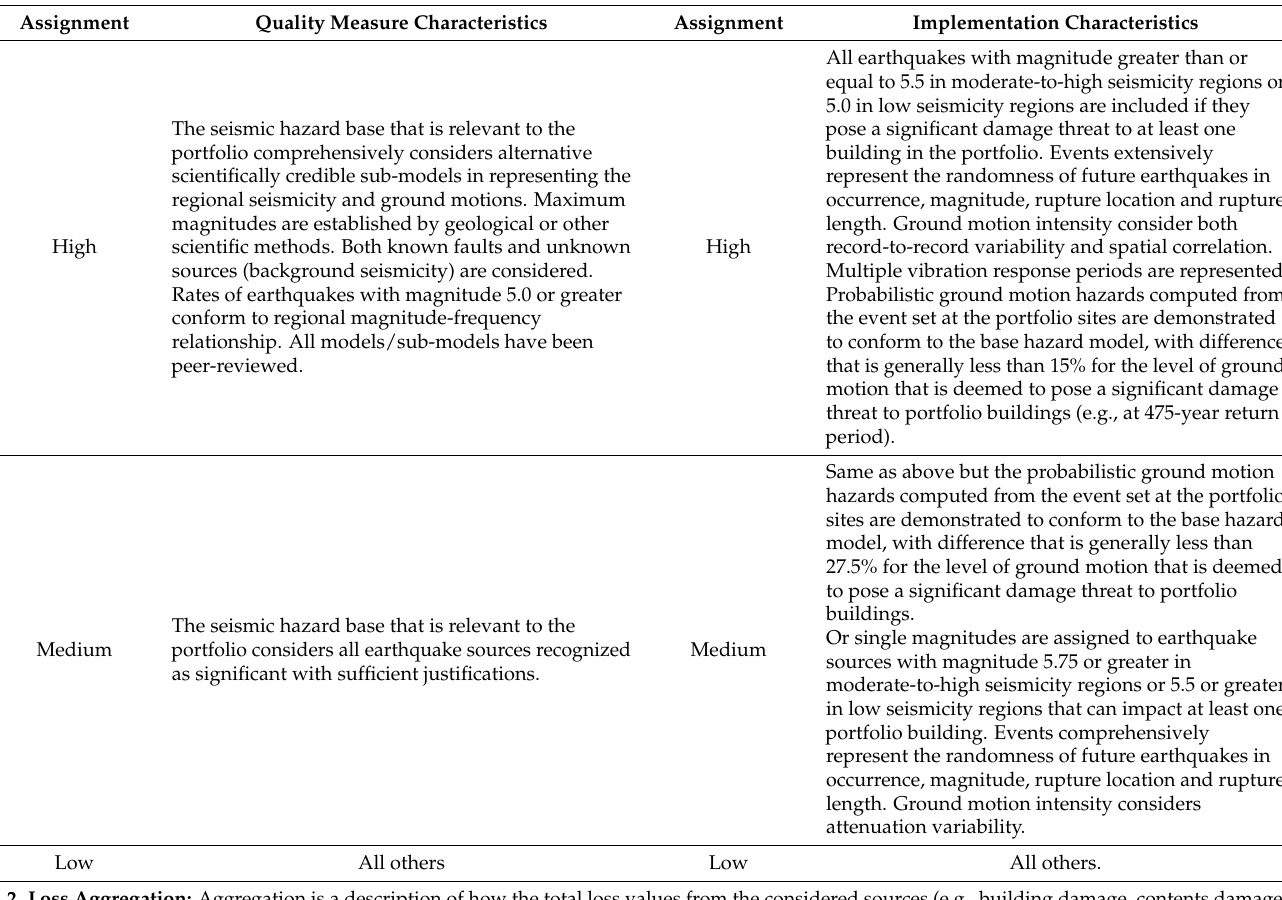
Table 8. Definitions of Quality Measure and Implementation characteristics for the components of the portfolio evaluation. For purposes of clarity, we characterize the portfolio component uncertainty by γ rather than the β used for single building